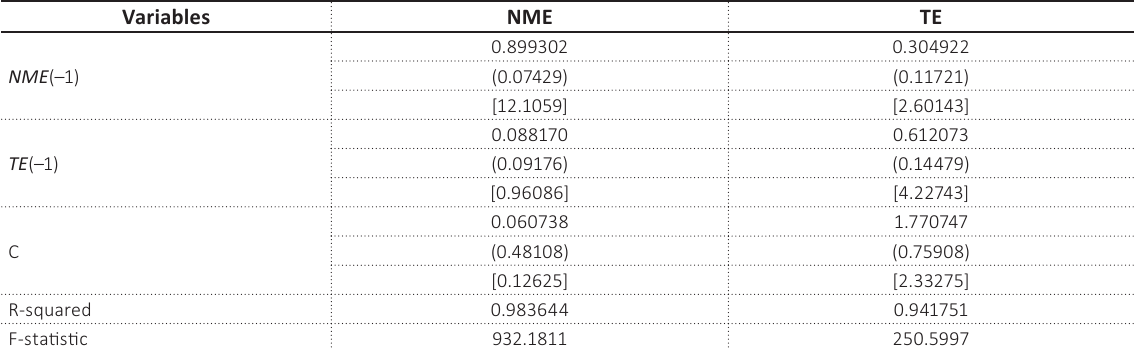
Table 3. Vector autoregression